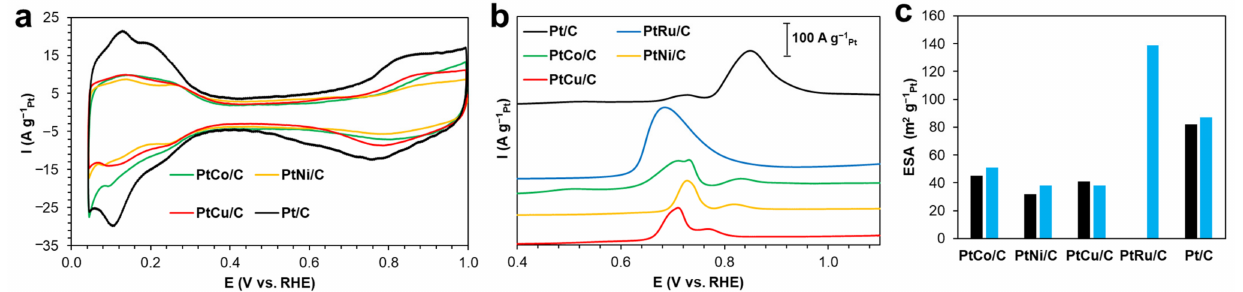
Figure 5. The CVs of the PtM/C and Pt/C electrodes after the activation stage ( a ); the CO stripping of the PtM/C and Pt/C samples, the electrolyte is the 0.1 M HClO 4 solution saturated with Ar at atmospheric pressure ( b ); the ESA values determined by the adsorption/desorption of hydrogen (black bars) and CO stripping (blue bars) ( c